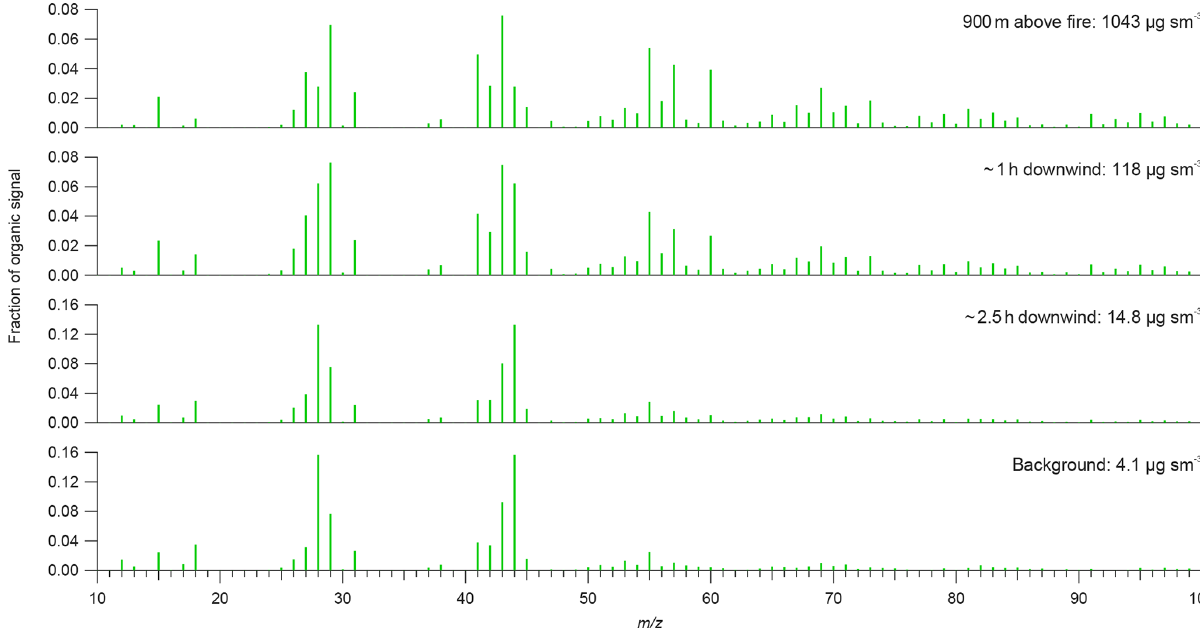
Figure 4. Aerosol mass spectrometer organic mass spectra from different segments of the case study analysis from flight B737. The above- fire mass spectrum is from sampling directly above the fire during a cross-plume intercept, with the two downwind mass spectra measured during the along-plume straight-and-level run (SLR), while the background mass spectrum is in the regional aerosol haze away from the main fire plume study region.